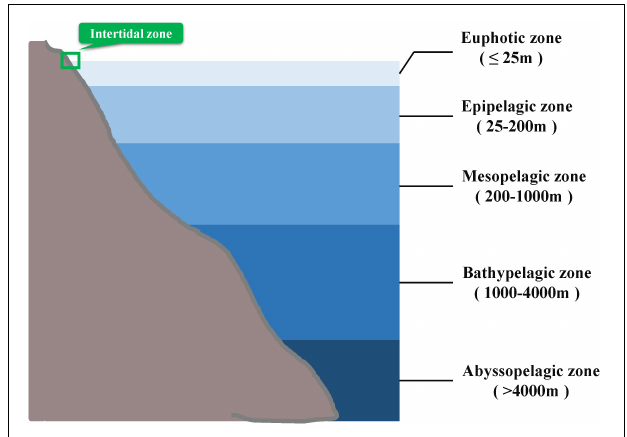
FIGURE 1 | Division of different photic layers in the ocean according to reference (Arístegui et al., 2009). Mudskippers are mainly distributed in the intertidal zone marked in green